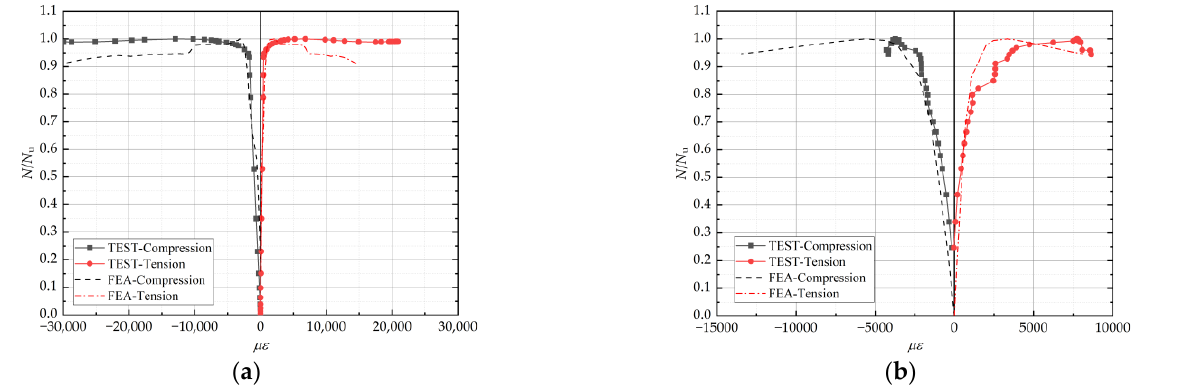
Figure 20. Comparison of load – strain curves between the test and FEA ( a )HL-1; ( b ) WT-1.